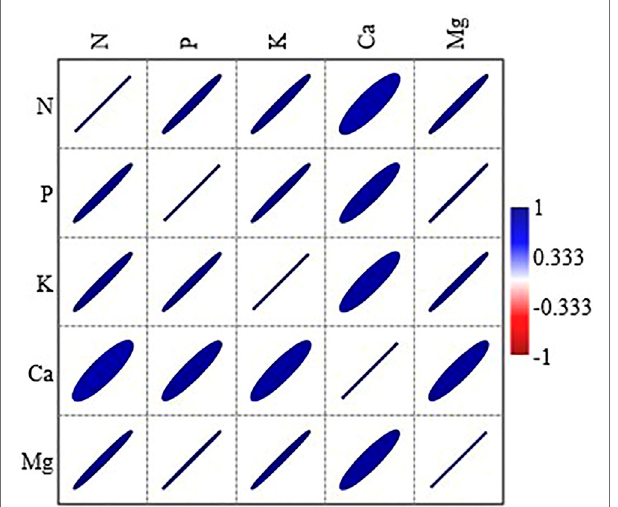
FIGURE 4 | Relationship between the annual return of macronutrients fromlitterfallamongalltheforesttypesandlitterfallcomponents.Forests:CTF, camphor tree forest; MPF, Masson pine forest; CMF, camphor tree and Masson pine mixed forest. Litter components: leaf litter, branch litter, and Miscellaneous litter. Pearson correlation is signi fi cant at p < 0.05; all the non-signi fi cant values are shown with a cross symbol.